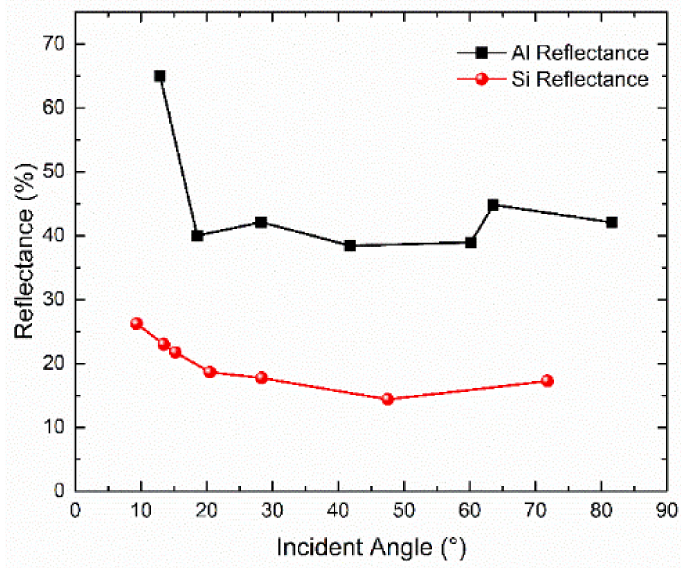
Figure 8. Reflectance of microfabricated silicon and aluminum reflectors at 795